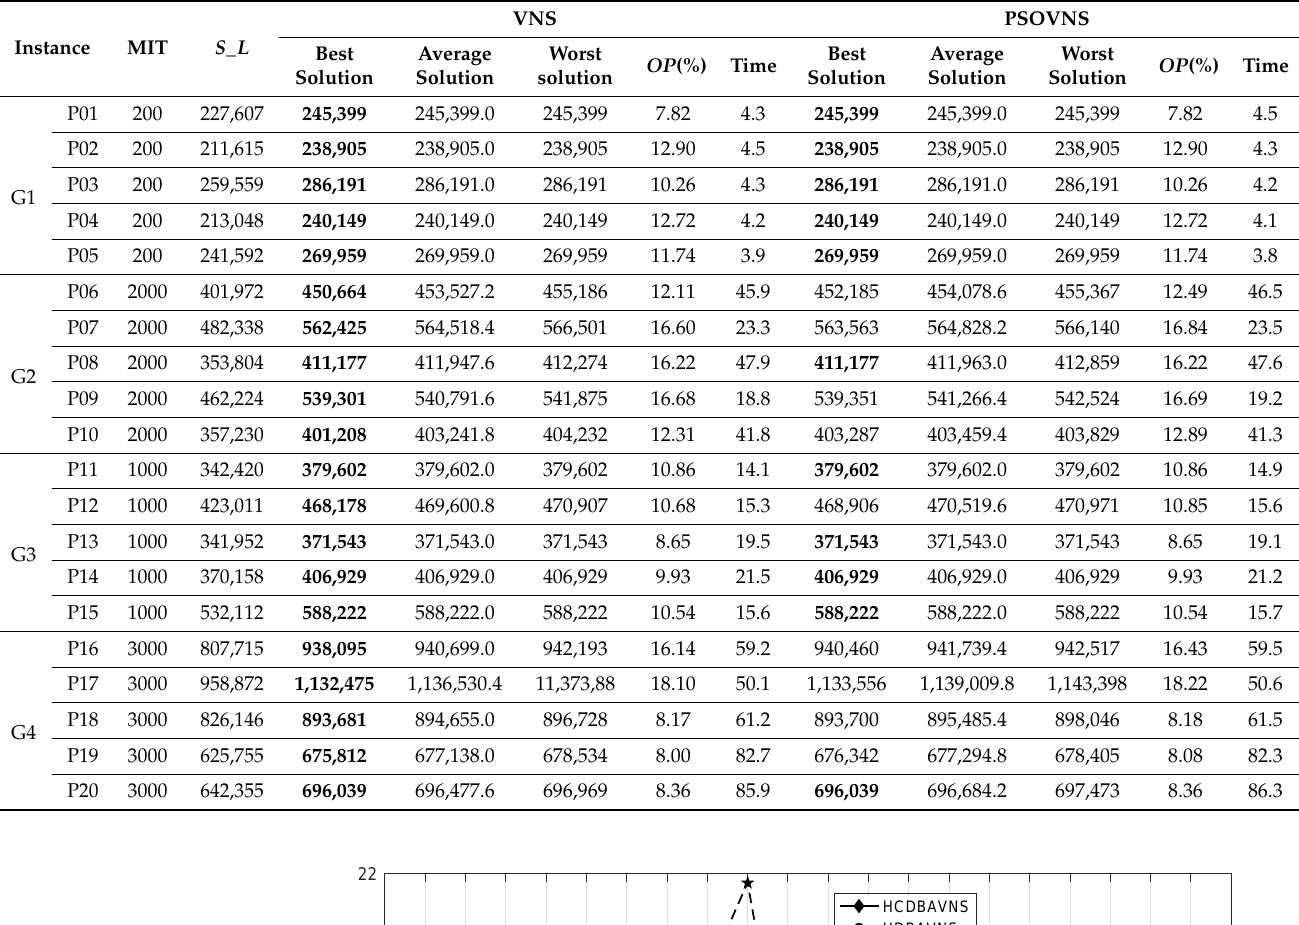
Table 12. Result of HCDBAVNS and HDBAVNS.